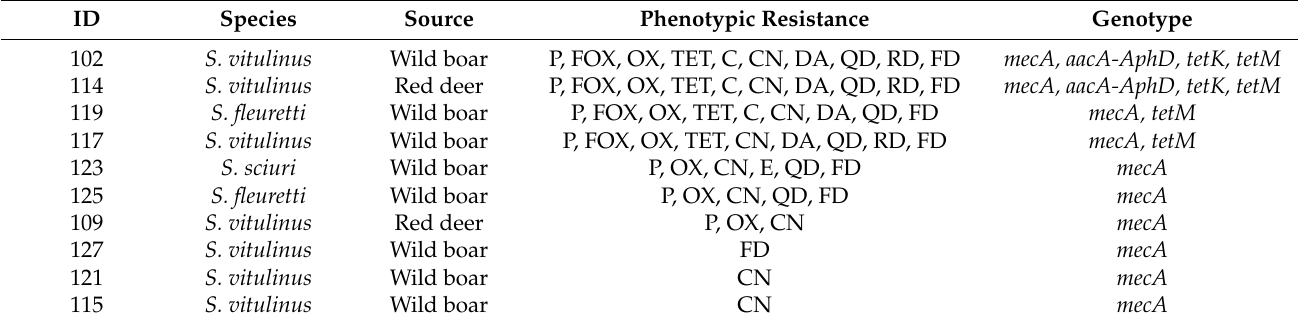
Table 1. Identification, origin and antibiotic resistance characteristics of the mecA -positive staphylococci